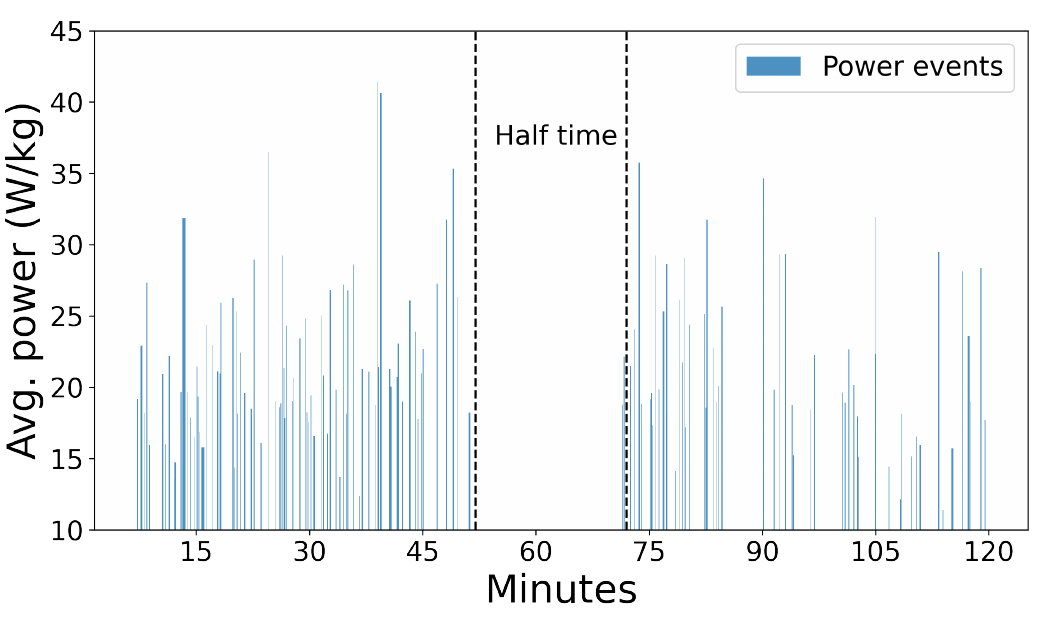
Figure 1. MPE in-game distribution for a single